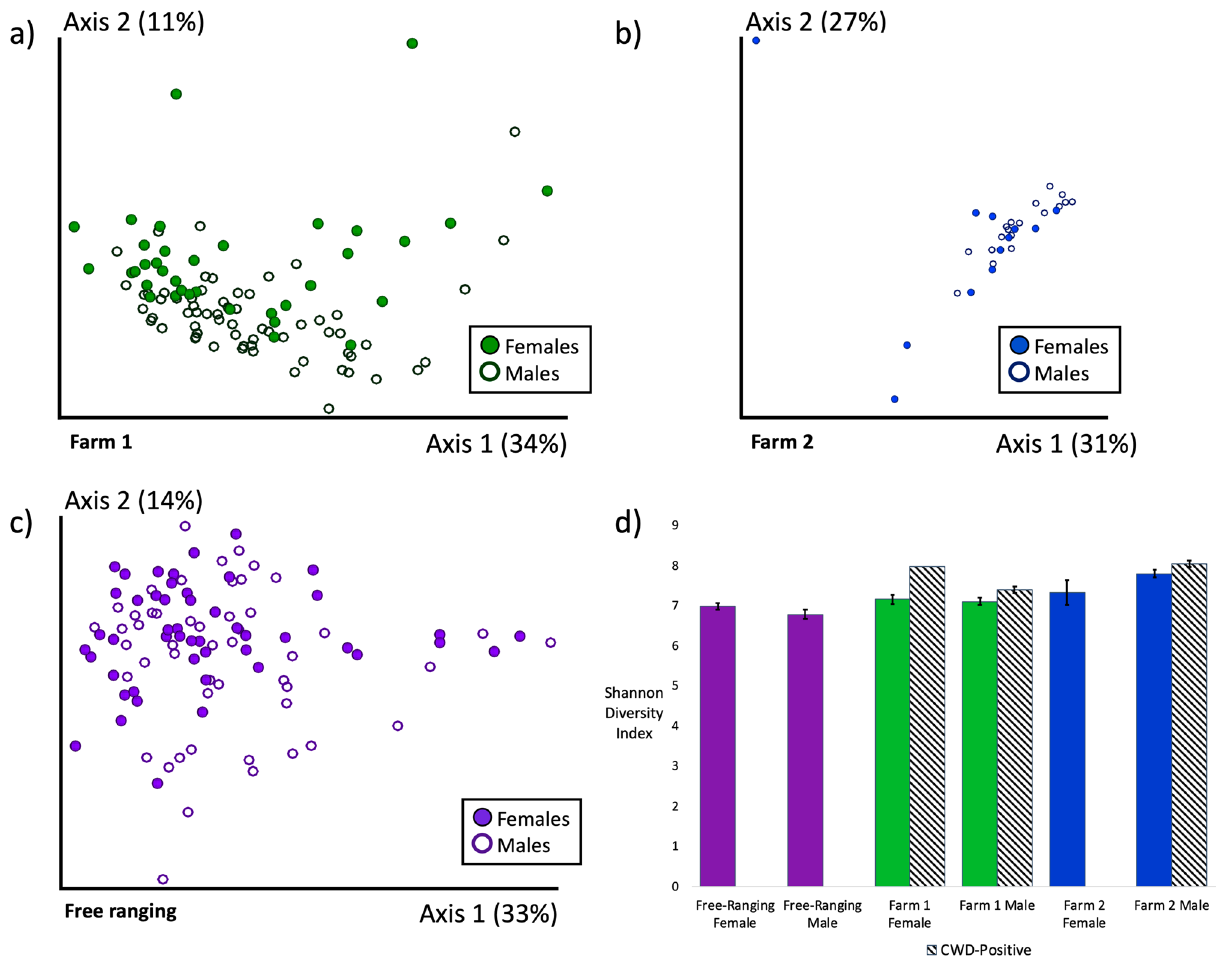
Farm 1 (PERMANOVA p = 0.008) and in Free-ranging deer (PERMANOVA p = 0.018), but not on Farm 2 (PERMANOVA p = 0.179). ( d ) Microbial diversity (Shannon diversity index) did not differ significantly by sex (Farm 1: p = 0.34, Farm 2: p = 0.15, Free-ranging: p = 0.53) or CWD status (Farm 1: p = 0.07, Farm 2: 0.26). Only CWD non-detect deer were included in statistical analyses by